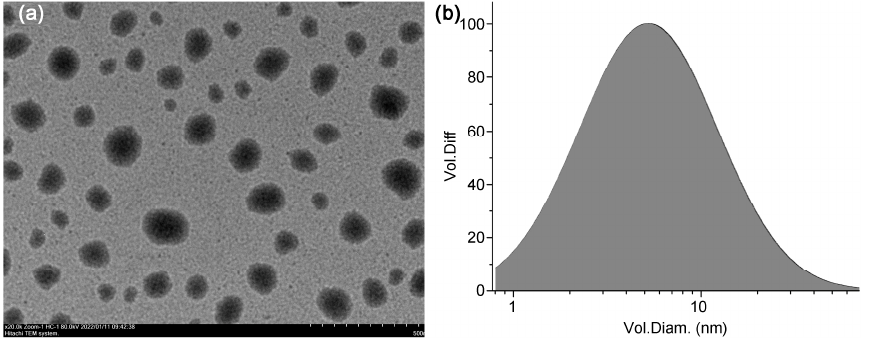
Figure 2. Morphological analysis and particle size of Nano-Thy. ( a ) TEM observation. ( b ) Particle size distribution. Nano-Thy was a light yellow clear and transparent liquid. Water soluble methylene blue and oil soluble Sudan III were used to determine the structure of Nano-Thy. The time-course observation (5 s, 15 s, and 5 min) indicated that the diffusion of methylene blue in Nano-Thy was faster than that of Sudan III (Figure 3). Methylene blue, but not Sudan III, was compatible with Nano-Thy, suggesting an O/W type of Nano-Thy. Figure 3. Diffusion process of two different dyestuffs in Nano-Thy. Blue and red indicated meth- ylene blue and Sudan Ⅲ , respectively. The thermodynamic stability of Nano-Thy was detected by alternant hot-cold stor- age, and high-speed centrifugation. Precipitation and lamination were not observed after alternant storage of Nano-Thy at 4 °C and 40 °C for 24 h. Centrifuge at 1000 rpm for 30 min failed to change the appearance of Nano-Thy. These results suggested that Nano-Thy was a stable nano emulsion. 3.2. Nano-Thy Inhibited the Growth and Spore Germination of B. cinerea Nano-Thy significantly inhibited the mycelial growth of B. cinerea in a dose-depend- ent manner (Figure 4a). Compared to the control, the colony diameter significantly de- creased by 7.78%, 37.1%, 59.2%, and 74.9% at 0.1, 0.2, 0.4, and 0.8 mM Nano-Thy, respec- tively (Figure 4b). B. cinerea growth was not affected by the solvent for the preparation of nano-emulsion. These results indicated that Nano-Thy was able to inhibit the growth of B. cinerea .